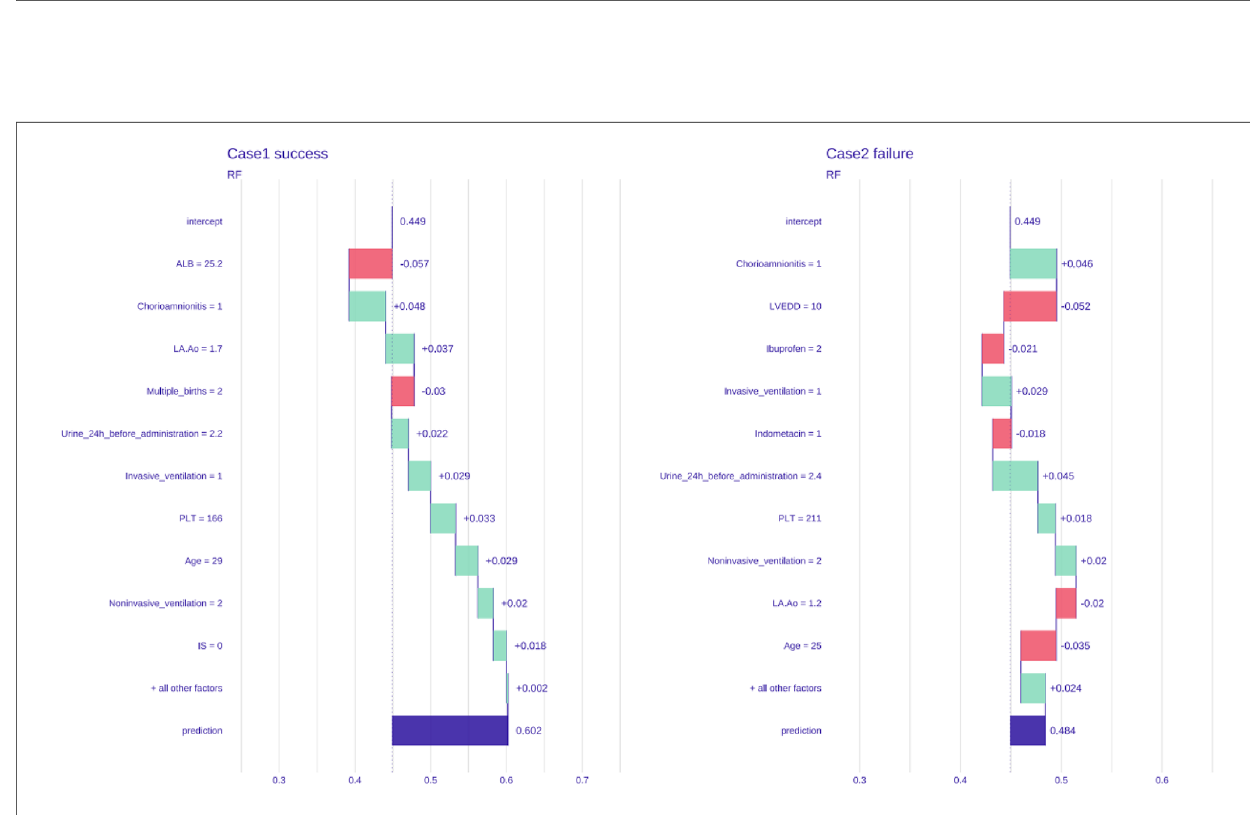
FIGURE 4 Marginal effect diagram of independent variable (top-three) and dependent variable. ALB, albumin; PLT,